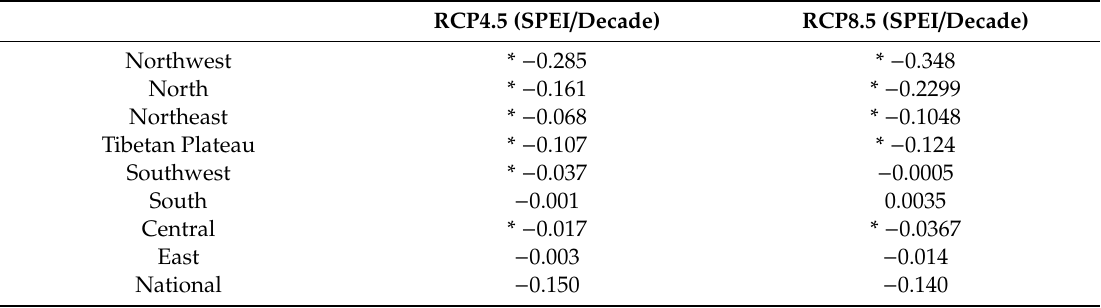
Table 3. MK test and Theil-Sen’s slope estimation for SPEI on a regional